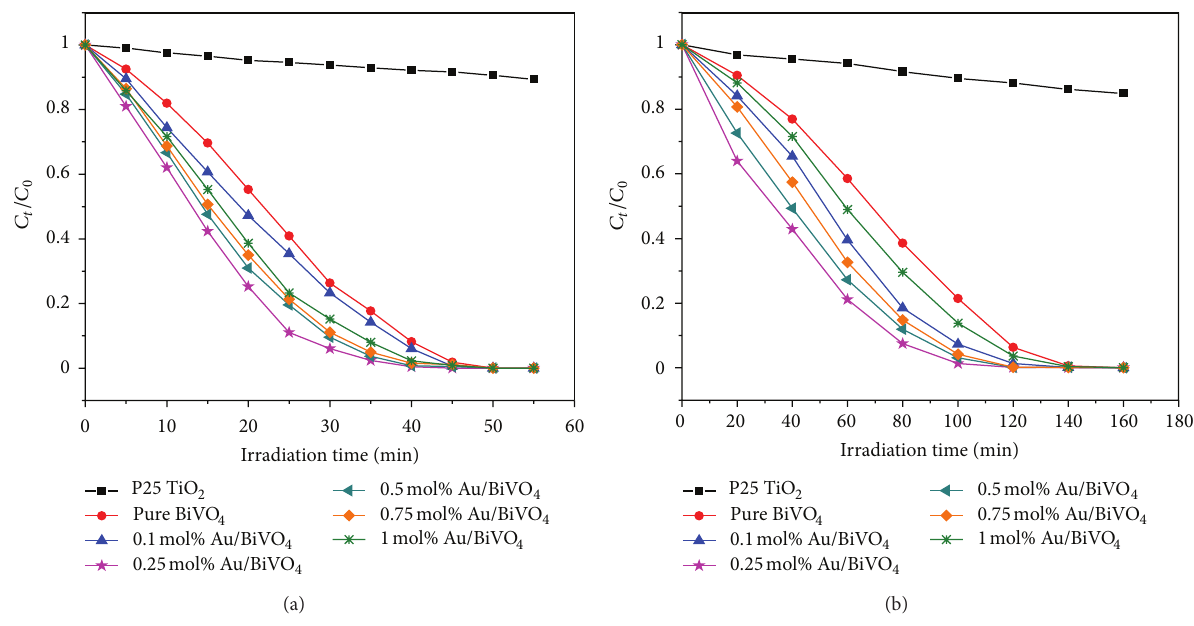
Figure 4: (a) Photocatalytic mineralization of (a) oxalic acid and (b) malonic acid over P25 TiO 2 , pure BiVO 4 , and different Au loaded on BiVO 4